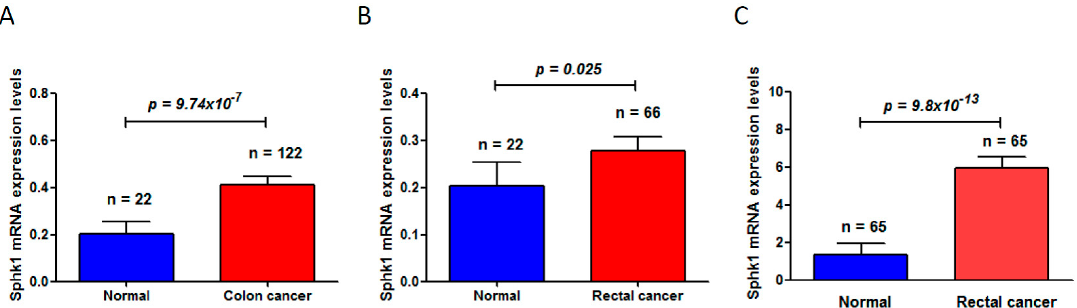
Figure 1. Sphingosine kinase 1 (Sphk1) mRNA levels were significantly increased in colorectal cancers, compared to the matched adjacent non-cancer adjacent tissues. ( A ) Sphk1 was increased in colon cancers (The Cancer Genome Atlas, TCGA, colorectal cancer dataset); ( B ) Sphk1 was increased in rectal cancers (TCGA colorectal cancer dataset); ( C ) Sphk1 was increased in rectal cancers (Oncomine dataset). “ n ” is the number of subjects studied in each group.